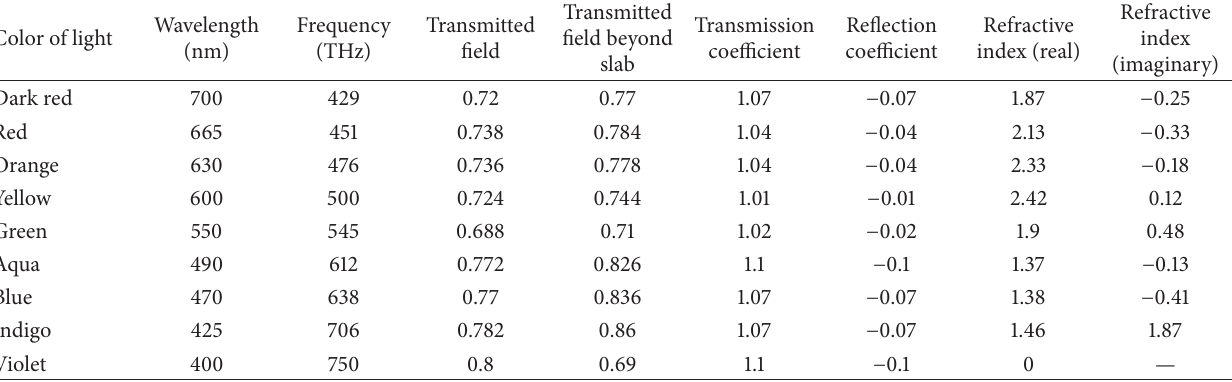
Table 5: Variations in different parameters of an optical cloaking system for a radius ratio of 2 with fixed inner (𝑟 𝑎 = 0.365 𝜇 m ) and outer = 0.730 𝜇 m ) radius. (𝑟 𝑏